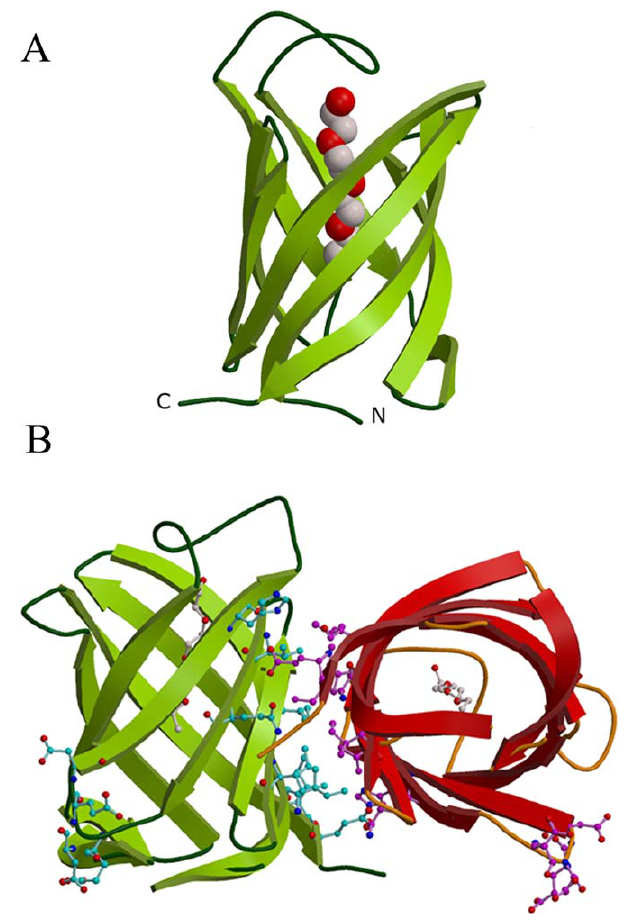
Figure 1. Overall Structure of GrlR with Bound Ligand (A) Ribbon diagram of monomer. The b -strands and the random coils/ turns are depicted in light and dark green colors, respectively. The Triton- X100 molecule is bound in the hydrophobic pore of the eight-stranded b -barrel. The CPK model of the ligand is shown with oxygen and carbon atoms colored in red and grey, respectively. (B) Ribbon diagram of the dimer. Monomer A is shown in red, monomer B in green. The dimeric interface residues, surface-exposed residues (EDED motif), and the ligand from both monomers are shown in ball and stick representation. This figure was drawn using Molscript and Raster3D